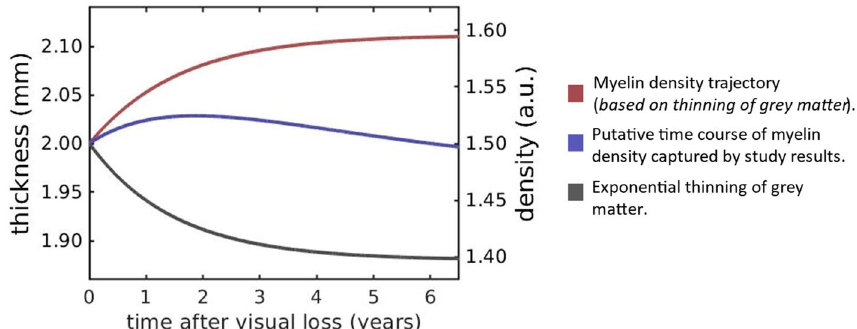
Figure 6. Time course of cortical atrophy. The grey line shows an exponential thinning of grey matter as measured on the left-hand axis. The red line shows how a constant volume of myelin would register as an increase in myelin density (right hand axis) because of the thinning of grey cortex (shown by the grey line). The blue line shows a putative time course of myelin density that first increases because the thinning of cortex dominates, but later decreases because of a genuine loss of myelinated tissue. The blue line therefore captures our results qualitatively; the patient group has a larger myelin density compared to controls, but the density is falling faster over